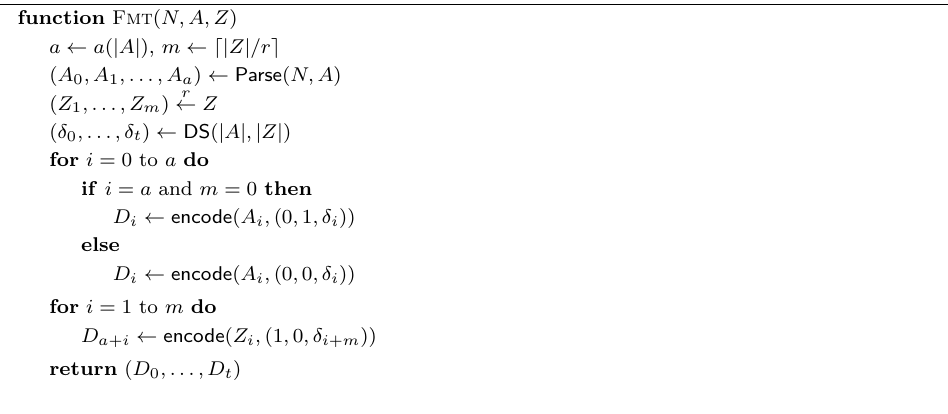
Algorithm 1 Description of the format function ( Fmt ) function Fmt ( N,A,Z